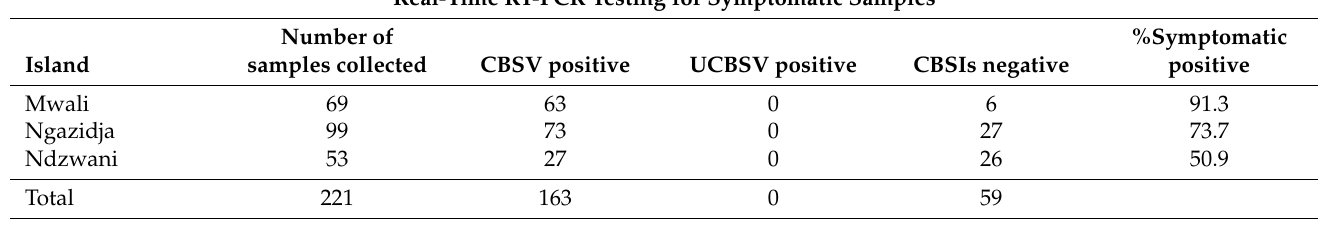
Table 3. Real-time RT-qPCR and PCR testing results for cassava brown streak ipomoviruses and cassava mosaic begomoviruses in cassava leaves collected from field plants in Comoros, July 2019. Real-Time RT-PCR Testing for Symptomatic